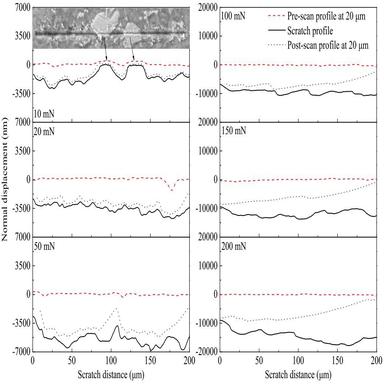
Pre-, formal- and post-scan scratch profiles under the CL routine with different pre-designed loading levels: 10, 20, 50, 100, 150 and 200 mN.